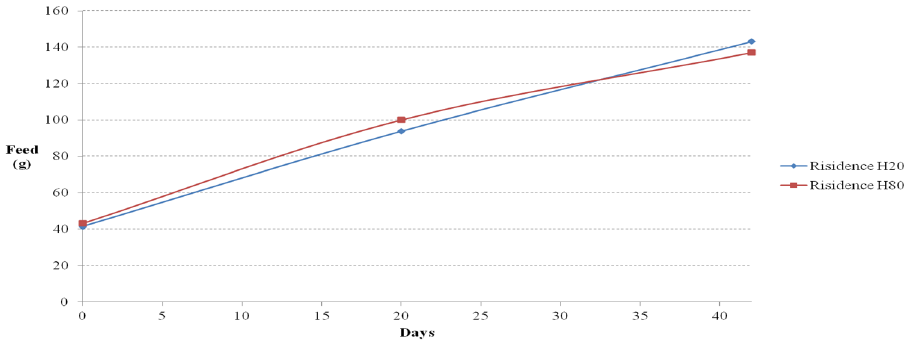
Figure 13. Food intake versus time curves (residence cages).